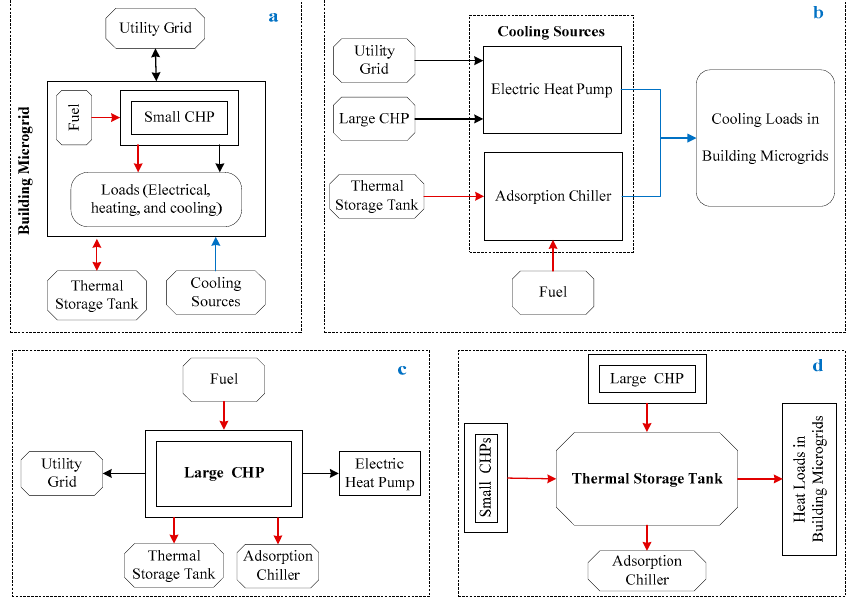
Figure 2. Energy balancing in the proposed multi-microgrid system: ( a ) CCHP in individual BMGs; ( b ) cooling energy; ( c ) large CHP; and ( d ) thermal storage tank.